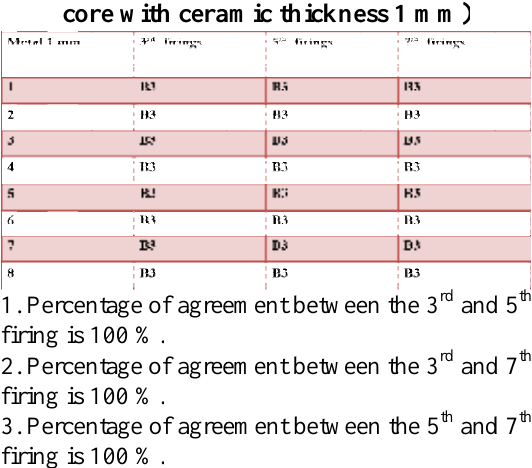
Table 8: Shade results of group C2 (metal